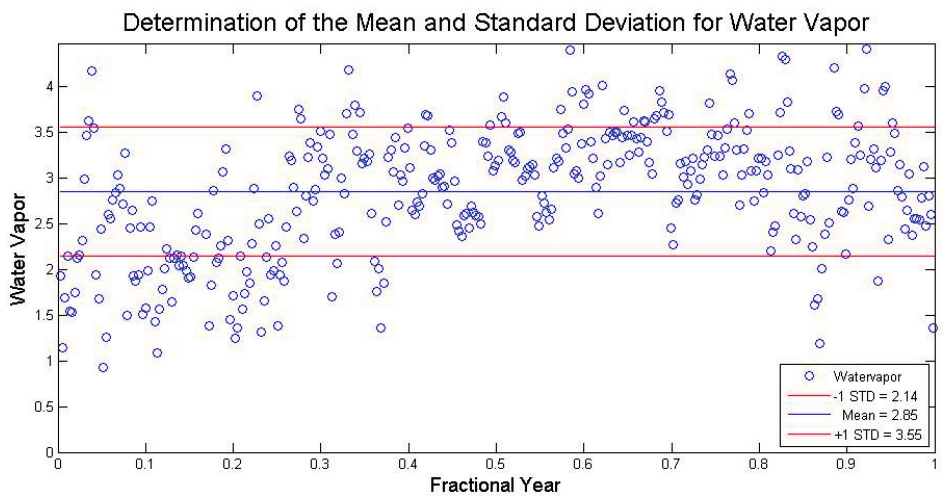
Figure 12. Water vapor levels over the Libya 4